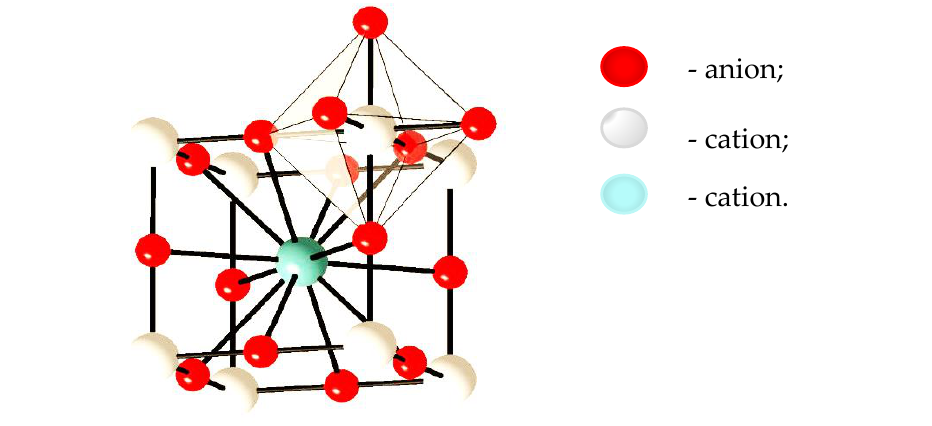
Figure 13. Crystal structure of MeO 6 perovskite.